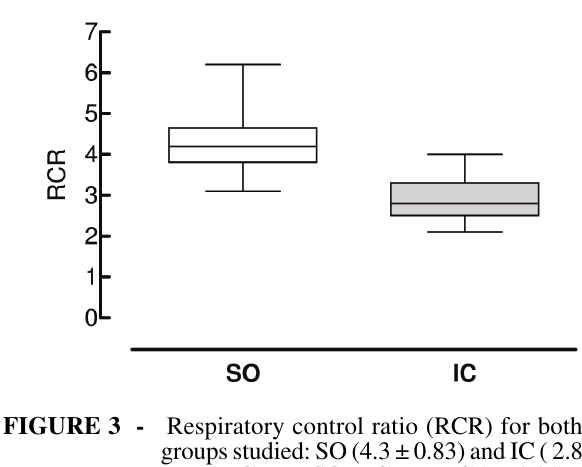
FIGURE 3 - Respiratory control ratio (RCR) for both groups studied: SO (4.3 ± 0.83) and IC ( 2.8 ± 0.64). Group SO vs Group IC (